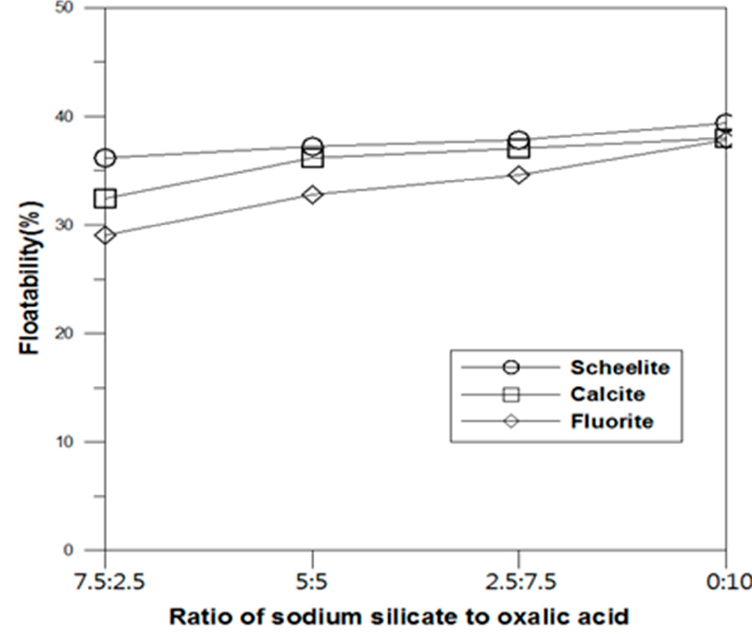
Figure 2. Floatability of scheelite, calcite, and fluorite in the function of the mixing ratio of sodium silicate and oxalic acid from 7.5:2.5 to 0:10.